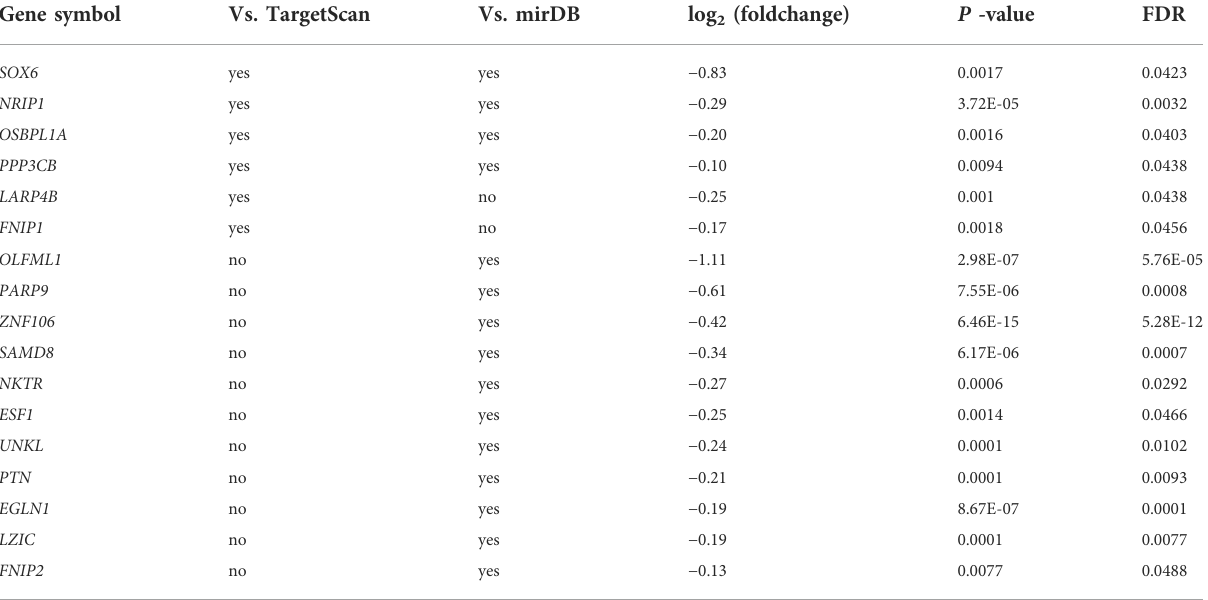
TABLE2ExpressionchangeofmiR-499-5ptargetgenesinmiR-499-5poverexpressingCPMscomparedwithnegativecontrol.TargetScanandmirDB were used for miR-499-5p target gene